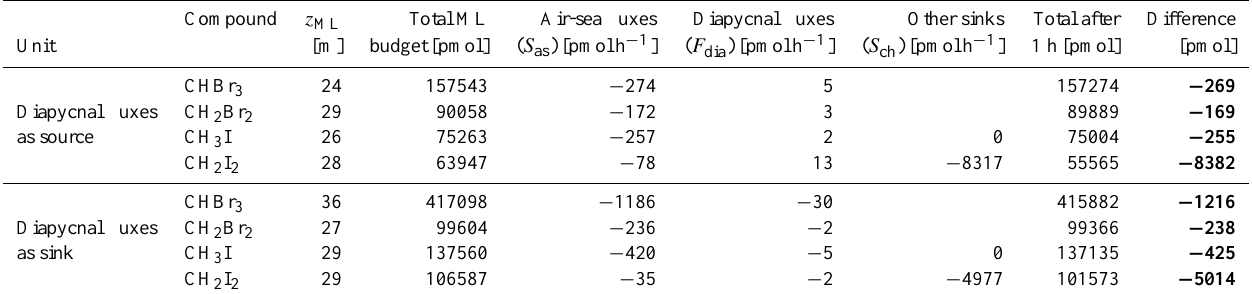
Table 6. Total mixed layer budget of each halocarbon, potential sinks and sources (box size 1 × 1 × z ML m 3 ). The upper four rows indicate cases where diapycnal fluxes act as sources, while the lower four rows summarize the budget for the cases where the diapycnal fluxes were sinks for the mixed layer budget. “Other sinks” is halogen substitution for CH 3 I and photolysis in case of CH 2 I 2 . The negative numbers indicate sinks for the budget.